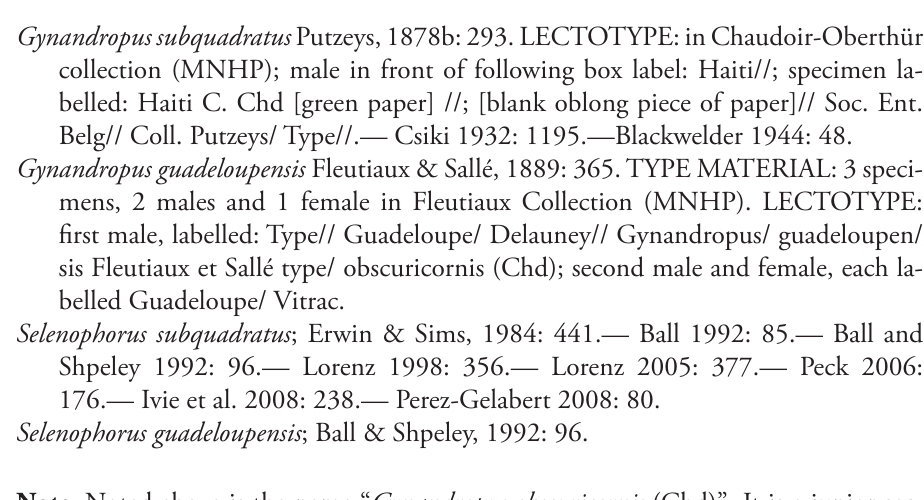
Selenophorus subquadratus (Putzeys) Figs 26, 28D–F,